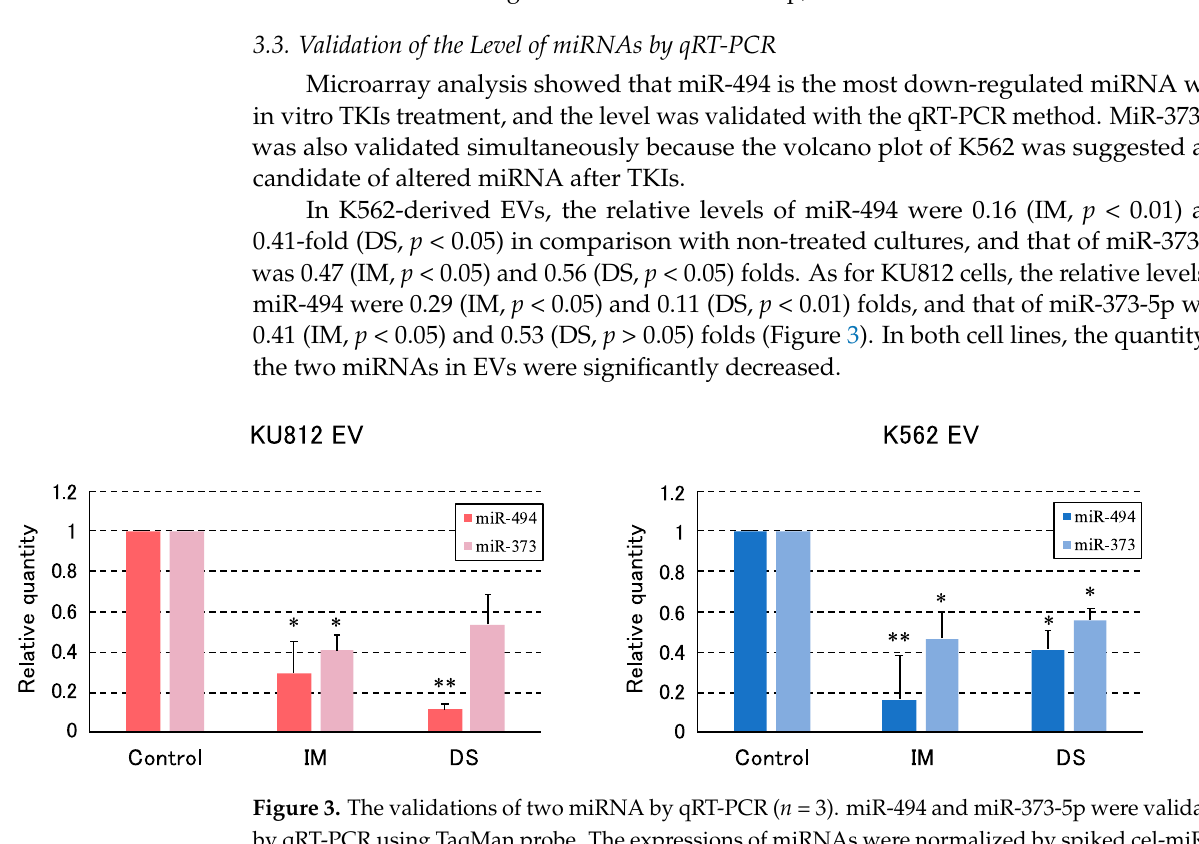
Figure 2. MiRNA microarray analysis in EV from two cell lines. ( A ) Heatmap and hierarchical clus- tering after TKIs treatments. Red or blue color indicate increased or decreased miRNA in EVs after TKIs treatment, respectively. Six miRNAs were clustered as the independent group. (IM: imatinib, DS: dasatinib) ( B ) Volcano plots from miRNA microarray analysis of two cell lines. For drawing volcano plots, the integrated data from both TKIs was used to detect commonly fluctuating miR- NAs.